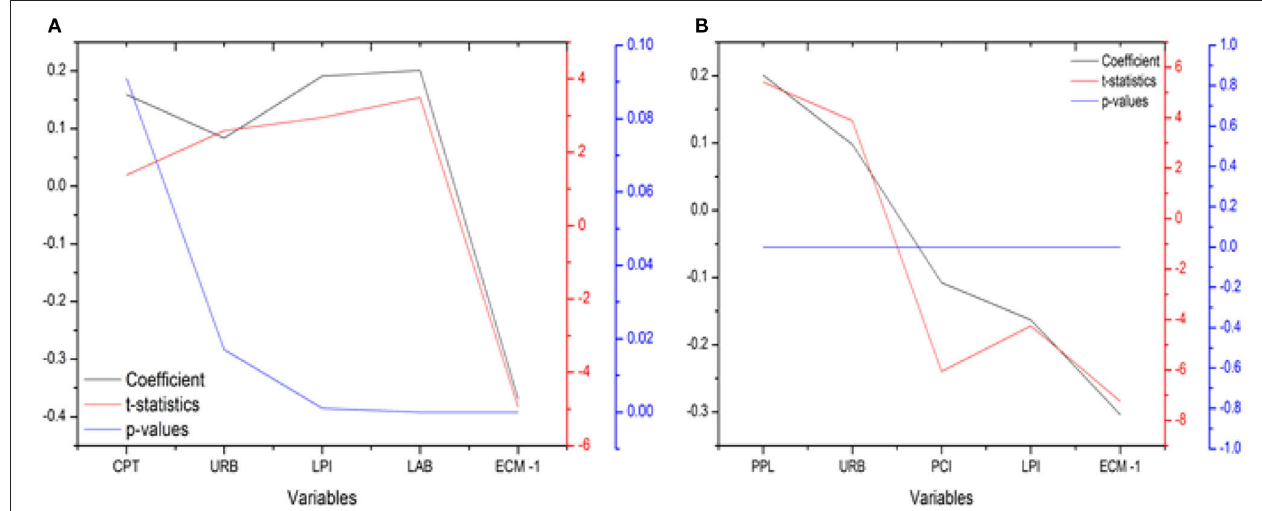
FIGURE 6 | Results of CS-ARDL Short run test (A) DV: EG, (B) DV: CE.